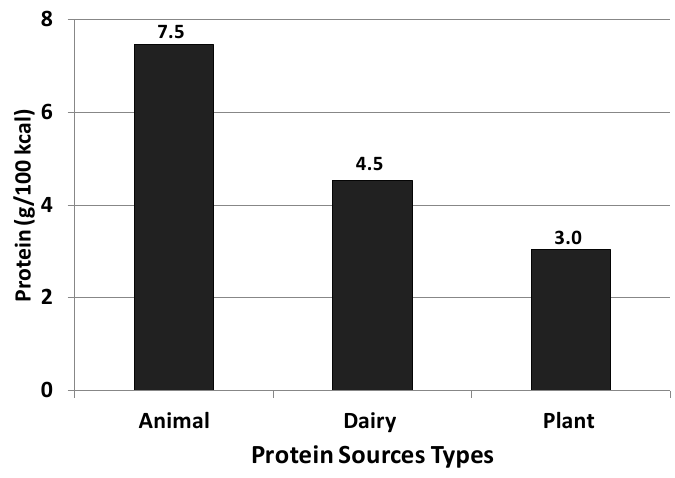
Figure 2. Protein density of animal protein foods *, dairy protein foods *, and plant protein foods *. (* Providing at least 1% animal, dairy or plant protein).